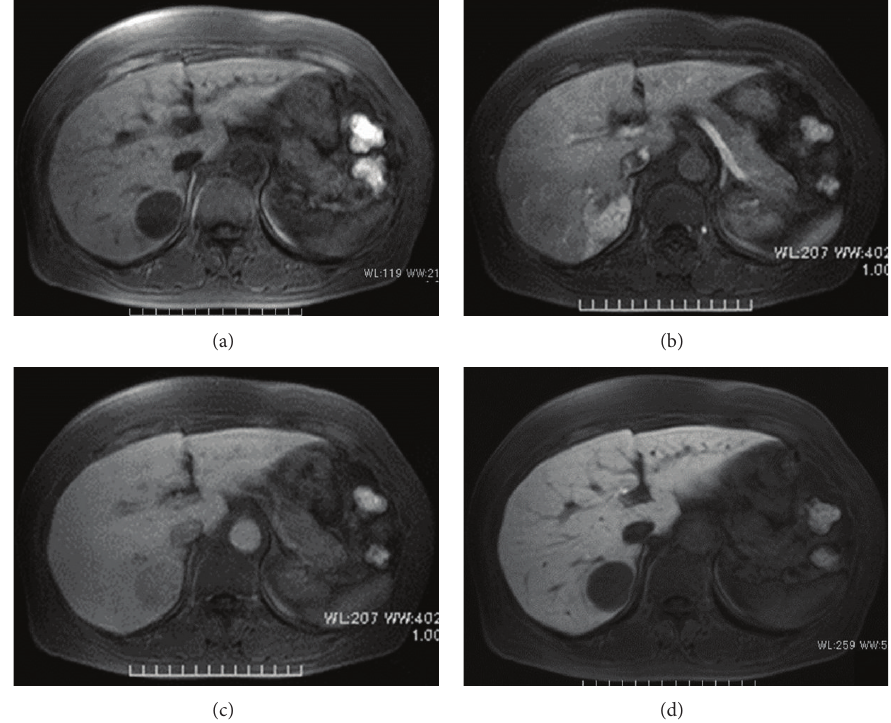
Figure 3: Dynamic contrast enhancement MRI with a hepatocyte-specific contrast agent (gadolinium-ethoxybenzyl-diethylenetriamine pentaacetic acid). Plain T1-weighted MRI revealed a low-intensity tumor (a), arterial phase hypervascularity (b), and a defective area visible in the late phase (c) and in the hepatic cellular phase